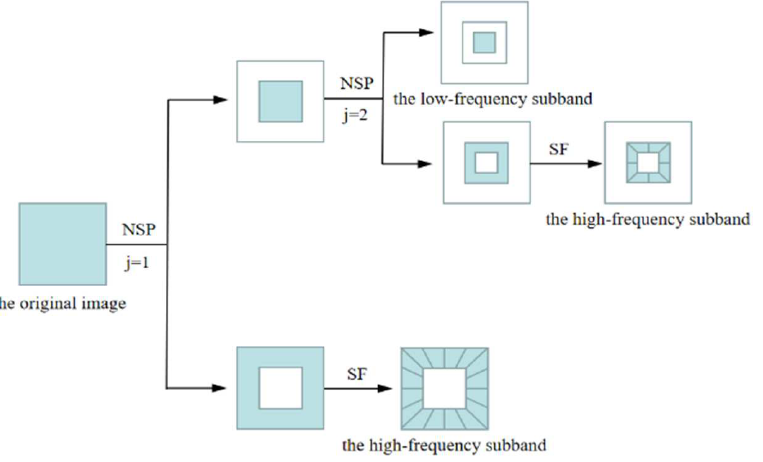
Figure 1. The flow chart of the NSST Transform.